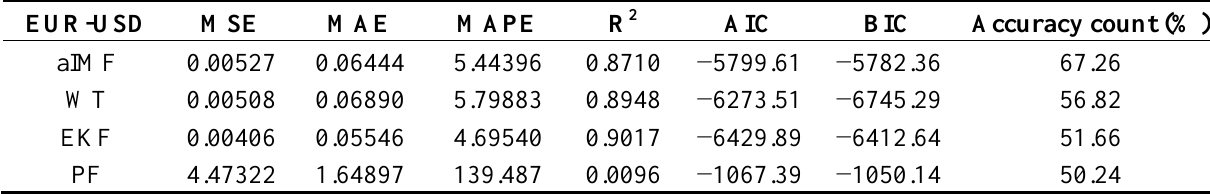
Table 5. Performance measurements of original datasets using noise distribution at 100% with 10 Hz and 10% amplitude of the original signals.